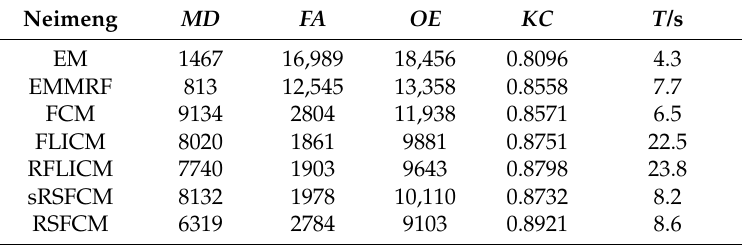
Table 6. Change detection results on Neimeng